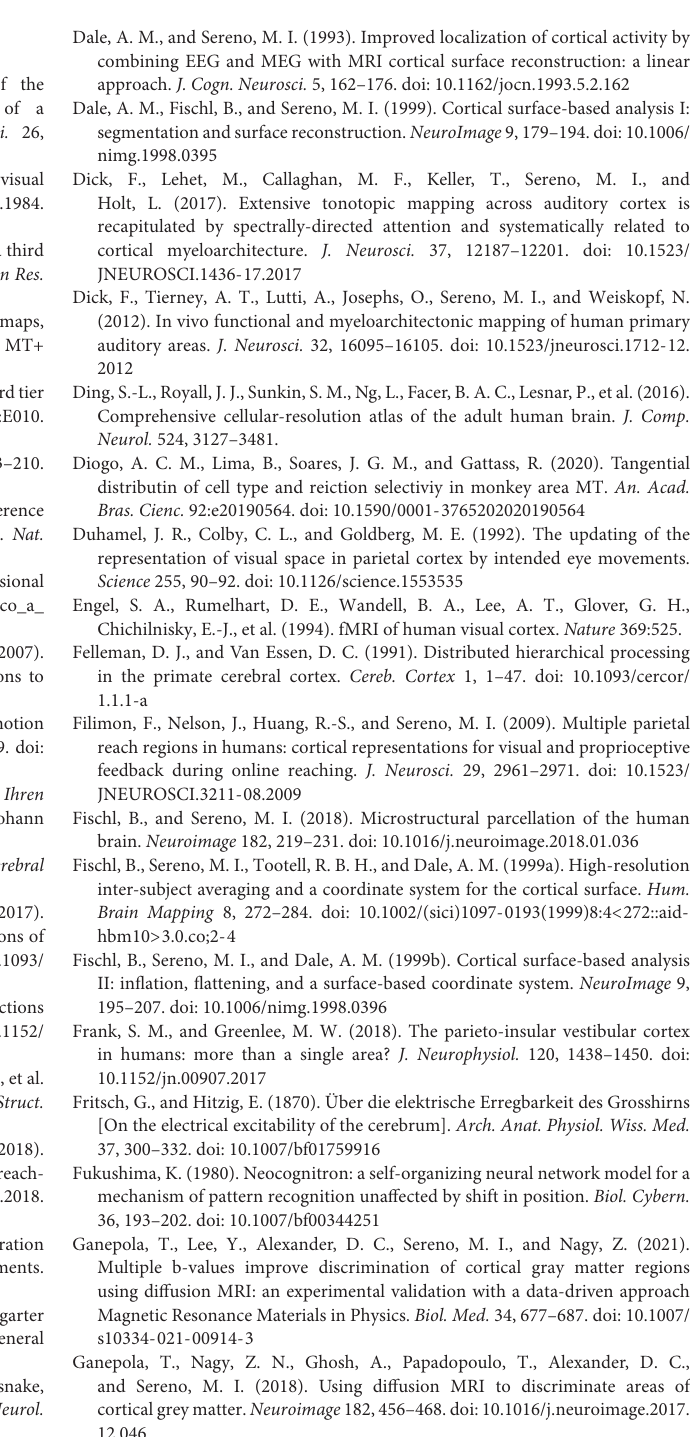
Supplementary Video 5 | The parcellation and map data from Supplementary Video 4 are displayed on the rotating inflated surfaces of the left and right hemisphere of FreeSurfer average subject, fsaverage (surface: inflated_avg) in the same order, using the same color scales, and at the same magnification as in Supplementary Video 4